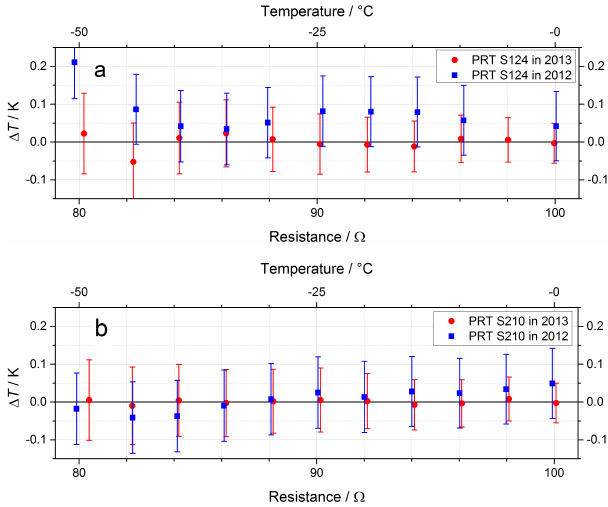
Fig.19. ThespectrallyresolvedradiationtemperatureoftheGBB-CmeasuredwiththevacuumFTSat on the optical surface. The respective ranges of the measurement uncertainty are depicted as shaded areas. The three measurement areas on the optical surface of the GBB-C are shown as circles in the inset.